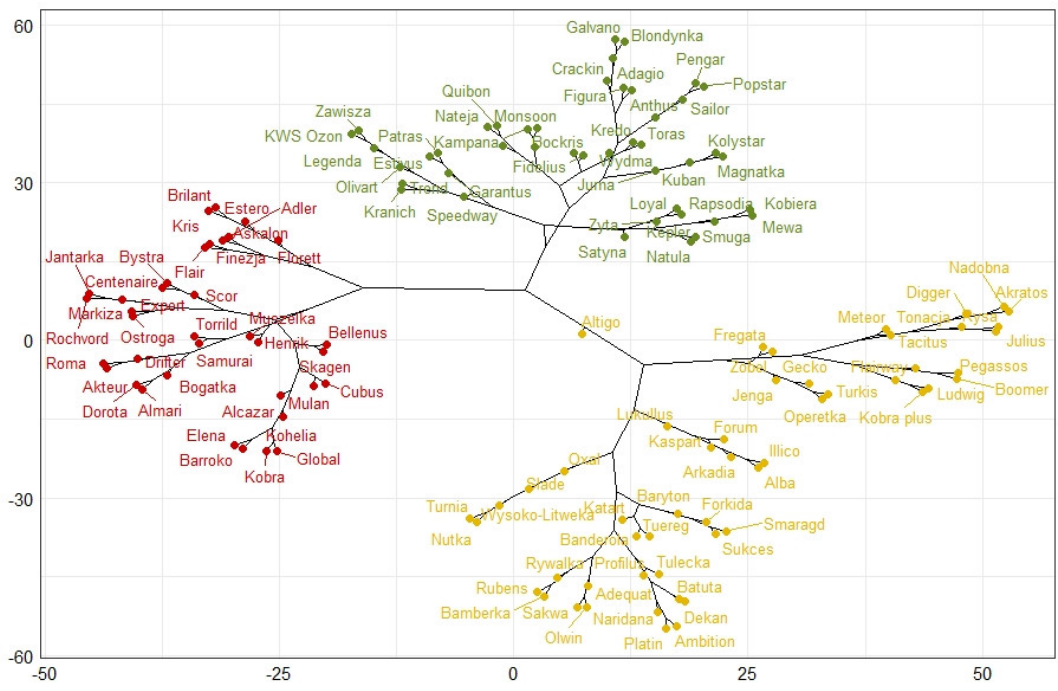
Figure 6. Distribution of the studied genotypes of plants using the method of hierarchical K−means in field conditions with the inoculation of R. solani (clustering in the form of a phylogenetic tree). The colors correspond to the assigned clusters according to the resistance type; red−susceptible, yellow−less susceptible, green−least susceptible.